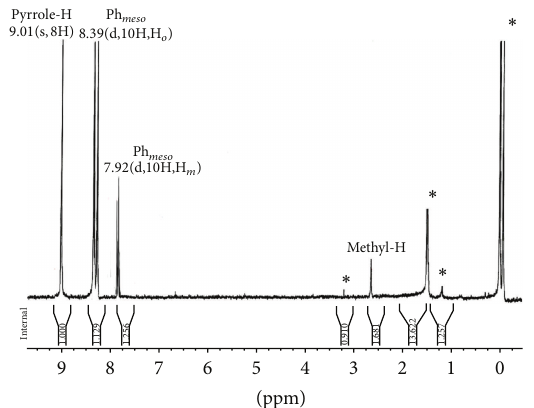
Figure 1: 1 H NMR spectra of p -NO 2 phO-Zn-t-( p -CH 3 )PP in CDCl3 at 298 K. Starred peaks are solvents impurities.